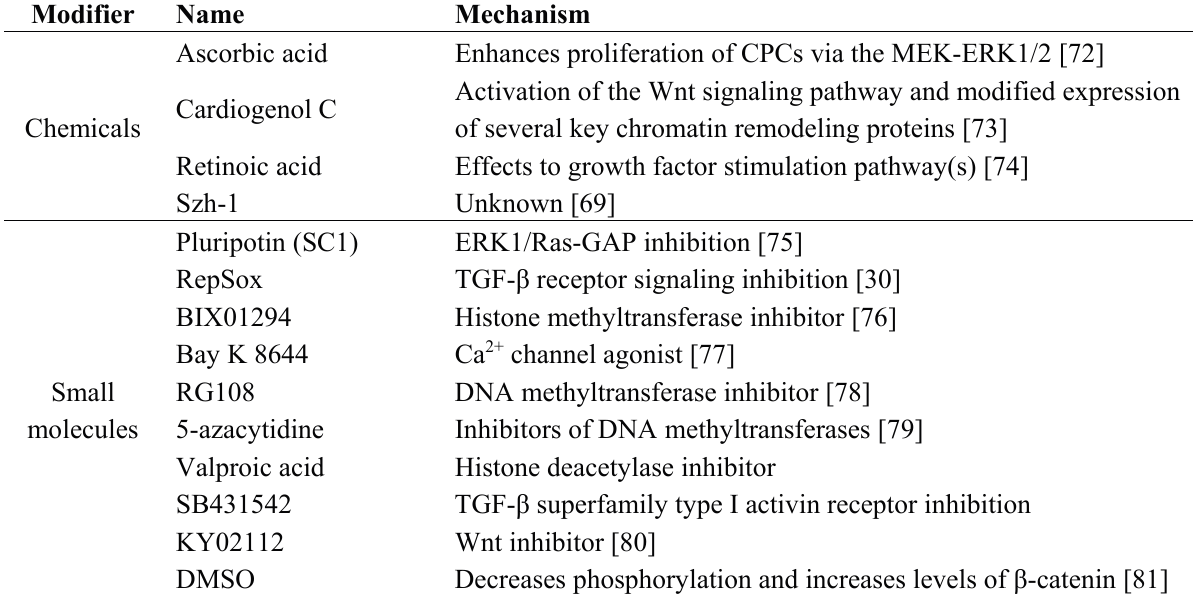
Table 3. Chemicals and small molecules used to differentiate iPSCs into